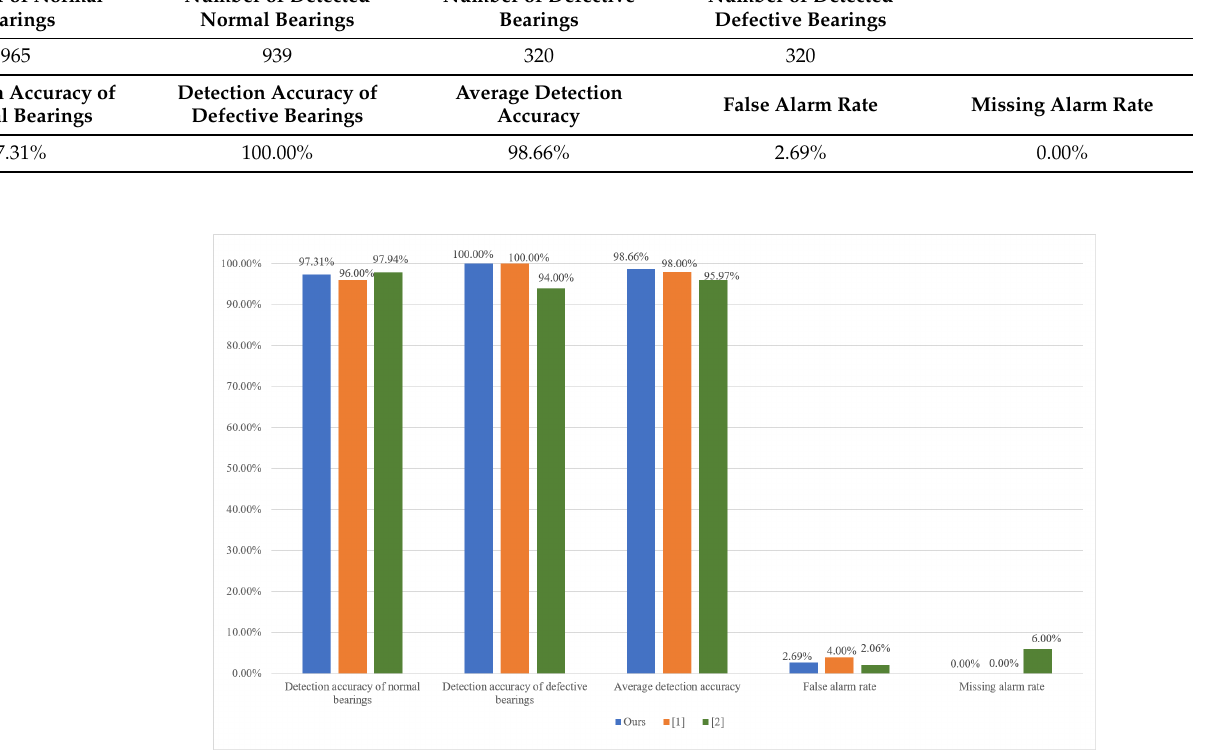
Figure 20. Comparison accuracy results between our method and